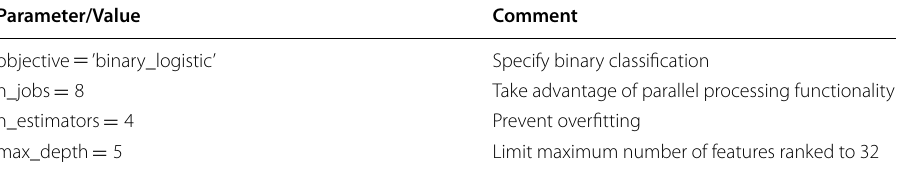
Table 5 Supervised ranking classifier XGBoost initialization options